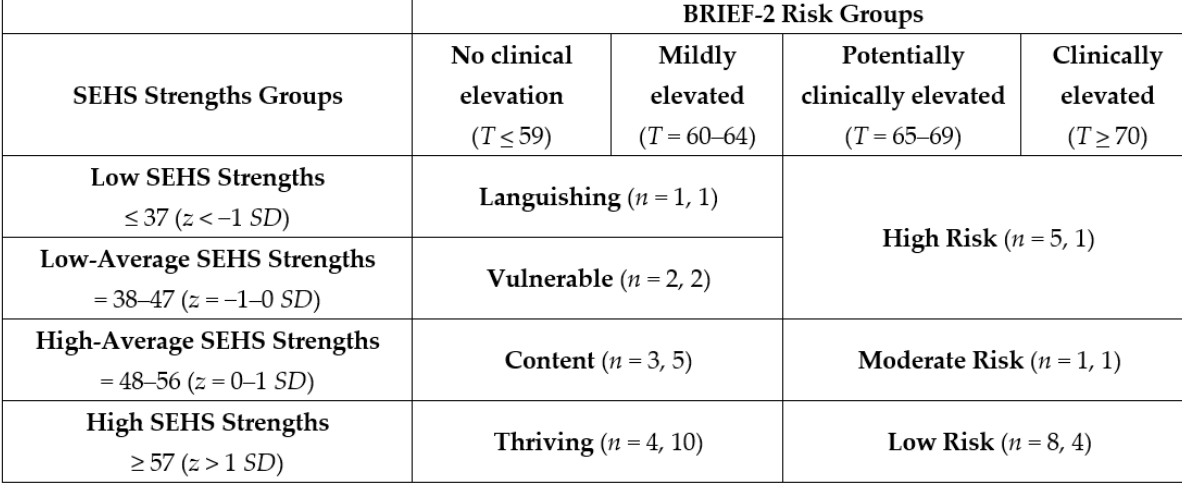
Table 6. Multidimensional group profiles measured over time.